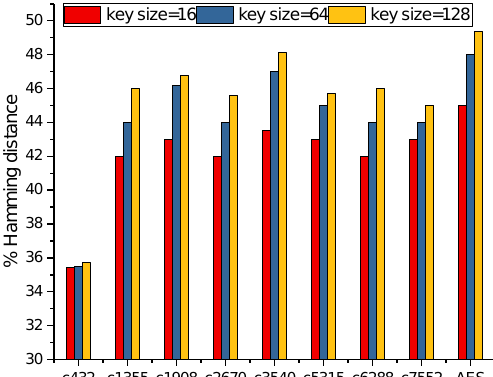
Figure 6. Hamming distance for wrong keys.